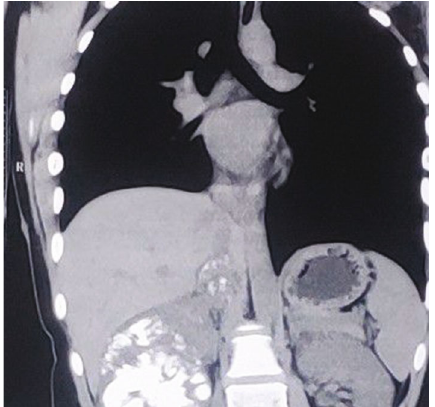
Figure 5: Histopathology showing renal